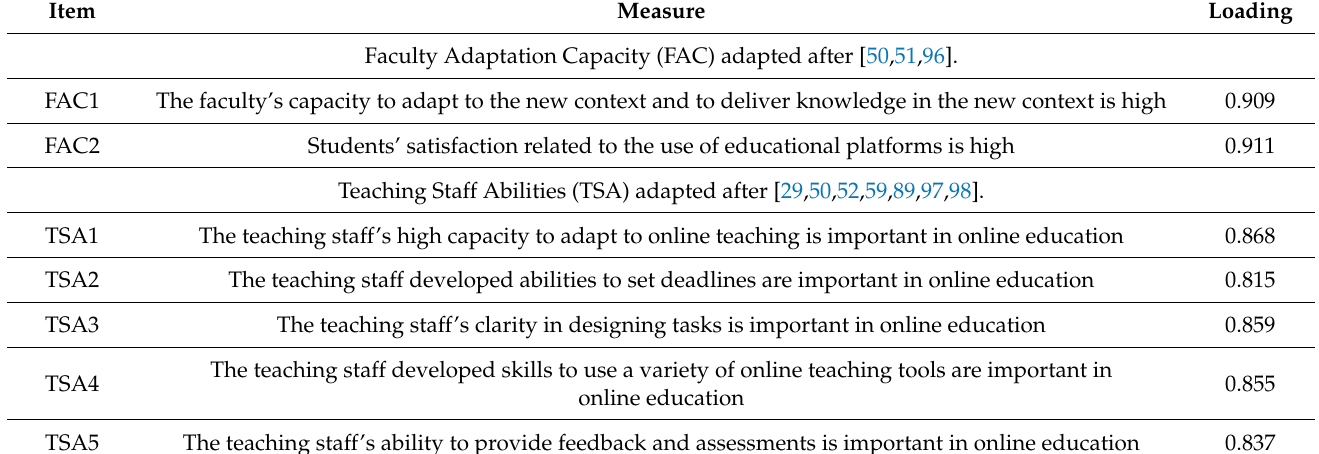
Table 1. Constructs and